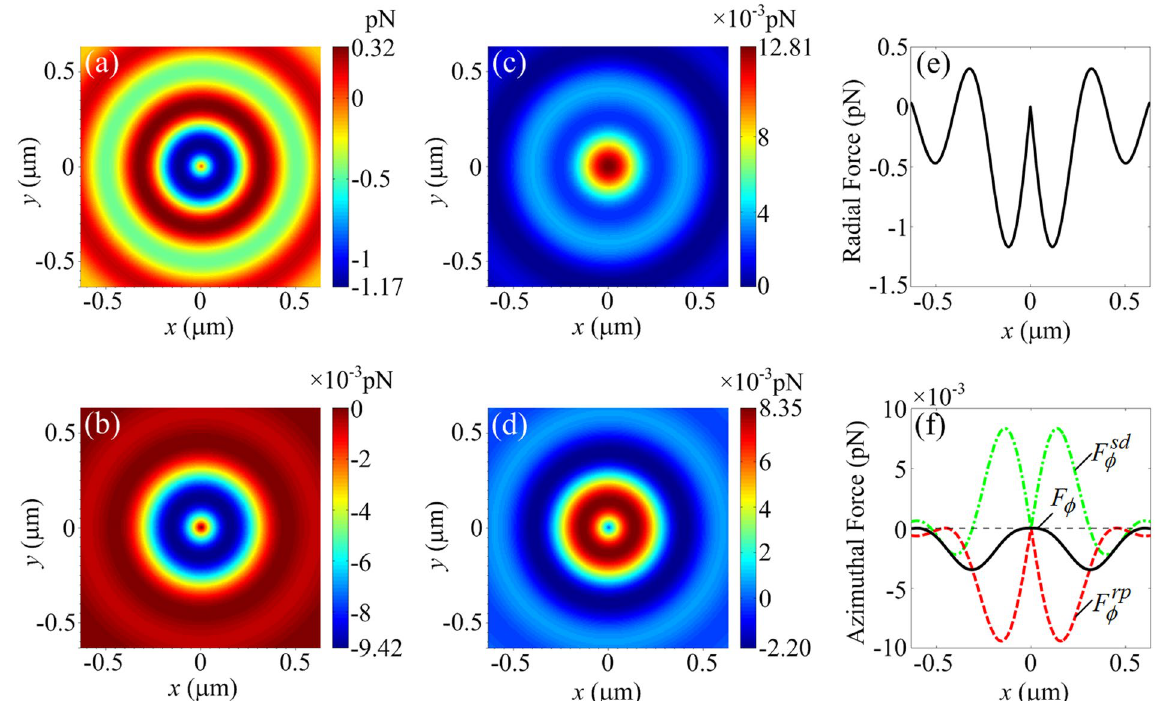
Figure 5. Optical forces on a 30 nm (radius) dielectric particle with n 2 = 1.6 located on the focal plane. ( a ) Radial gradient force. ( b ) and ( c ) Azimuthal and axial radiation pressures. ( d ) Azimuthal spin density force. ( e ) and ( f ) Total radial and azimuthal optical forces along the x